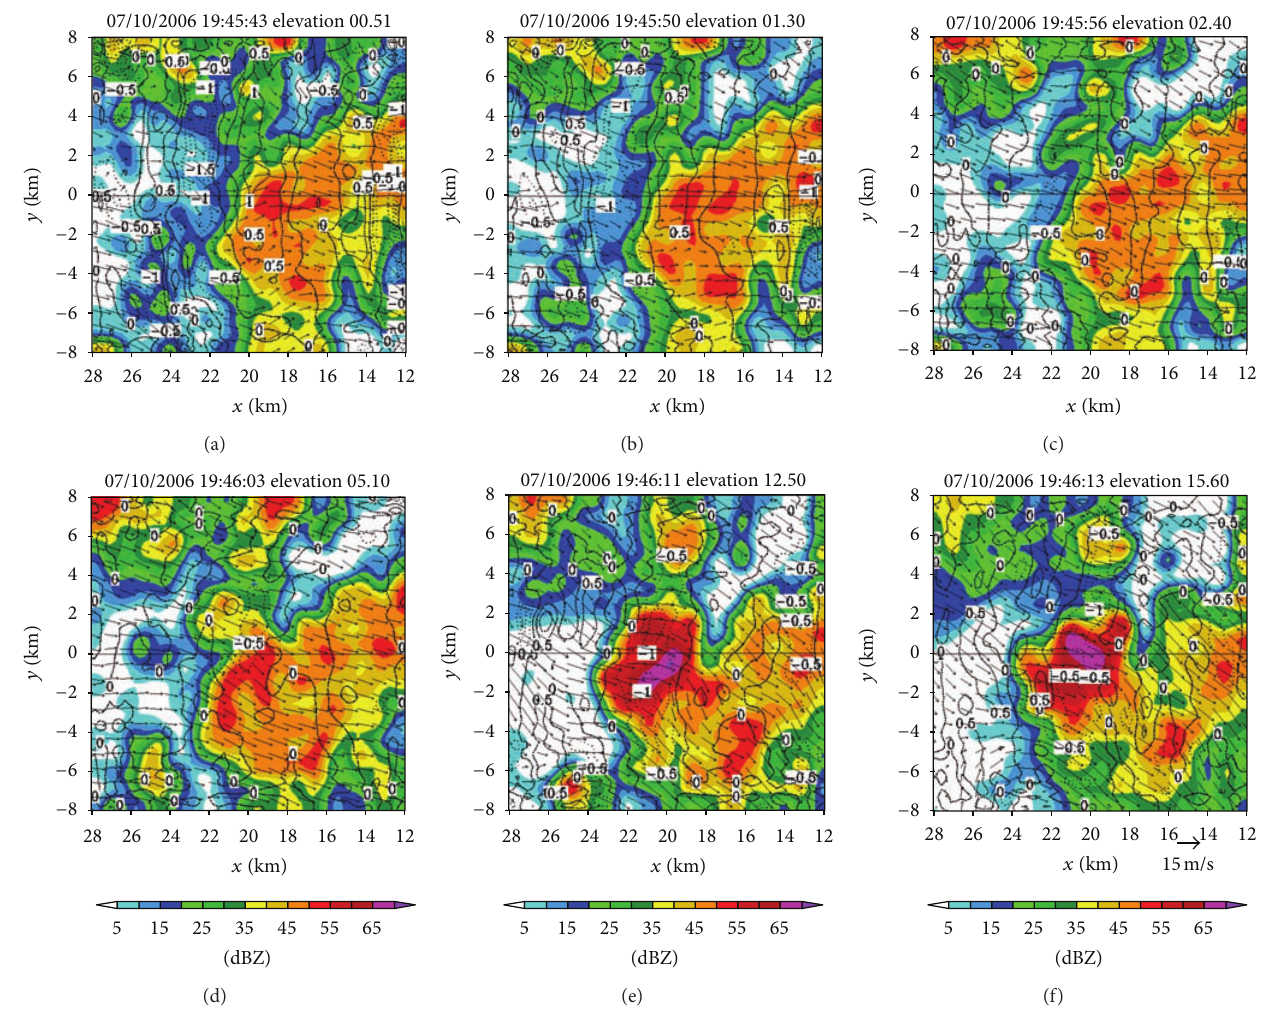
Figure 4: Quasi-horizontal ( 𝑢 𝑚 , V 𝑚 ) velocity fields (plotted by black arrows) retrieved in the nested domain on the conical surfaces of (a) 𝜃 = 0.51 ∘ , (b) 1.3 ∘ , (c) 2.4 ∘ , (d) 5.1 ∘ , (e) 12.5 ∘ , and (f) 15.6 ∘ from PAR 90 ∘ sector scans over the time period from 19 :44 :43 to 19: 46: 13 UTC on July 10, 2006. In each panel, the colored field shows the PAR-observed reflectivity (gridded and smoothed by the spatial interpolation on each tilt), and the black contours (with solid for positive and dashed for zero and negative) plot the field of horizontal divergence. The reflectivity of color scale is shown at the bottom of the figure, and the velocity vector scale is shown at the low-right corner of the figure. The nested domain size is 16 × 16km 2 (as marked by the red square box in Figure 3(b)). The 𝑥 -coordinate is originated from the PAR site and directed along the 210.7 ∘ azimuth (as shown by the dashed yellow line in Figure